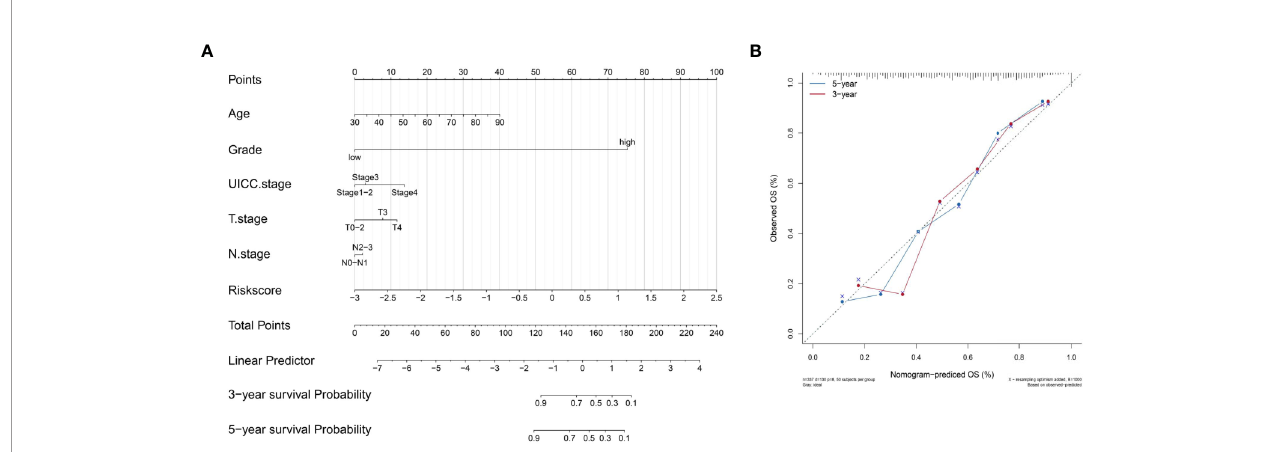
FIGURE 9 | Construct nomogram. (A) Nomograms for predicting the probability of patient mortality based on IRL-signature and clinical variables. (B) The calibration plot for internal validation of the nomogram.